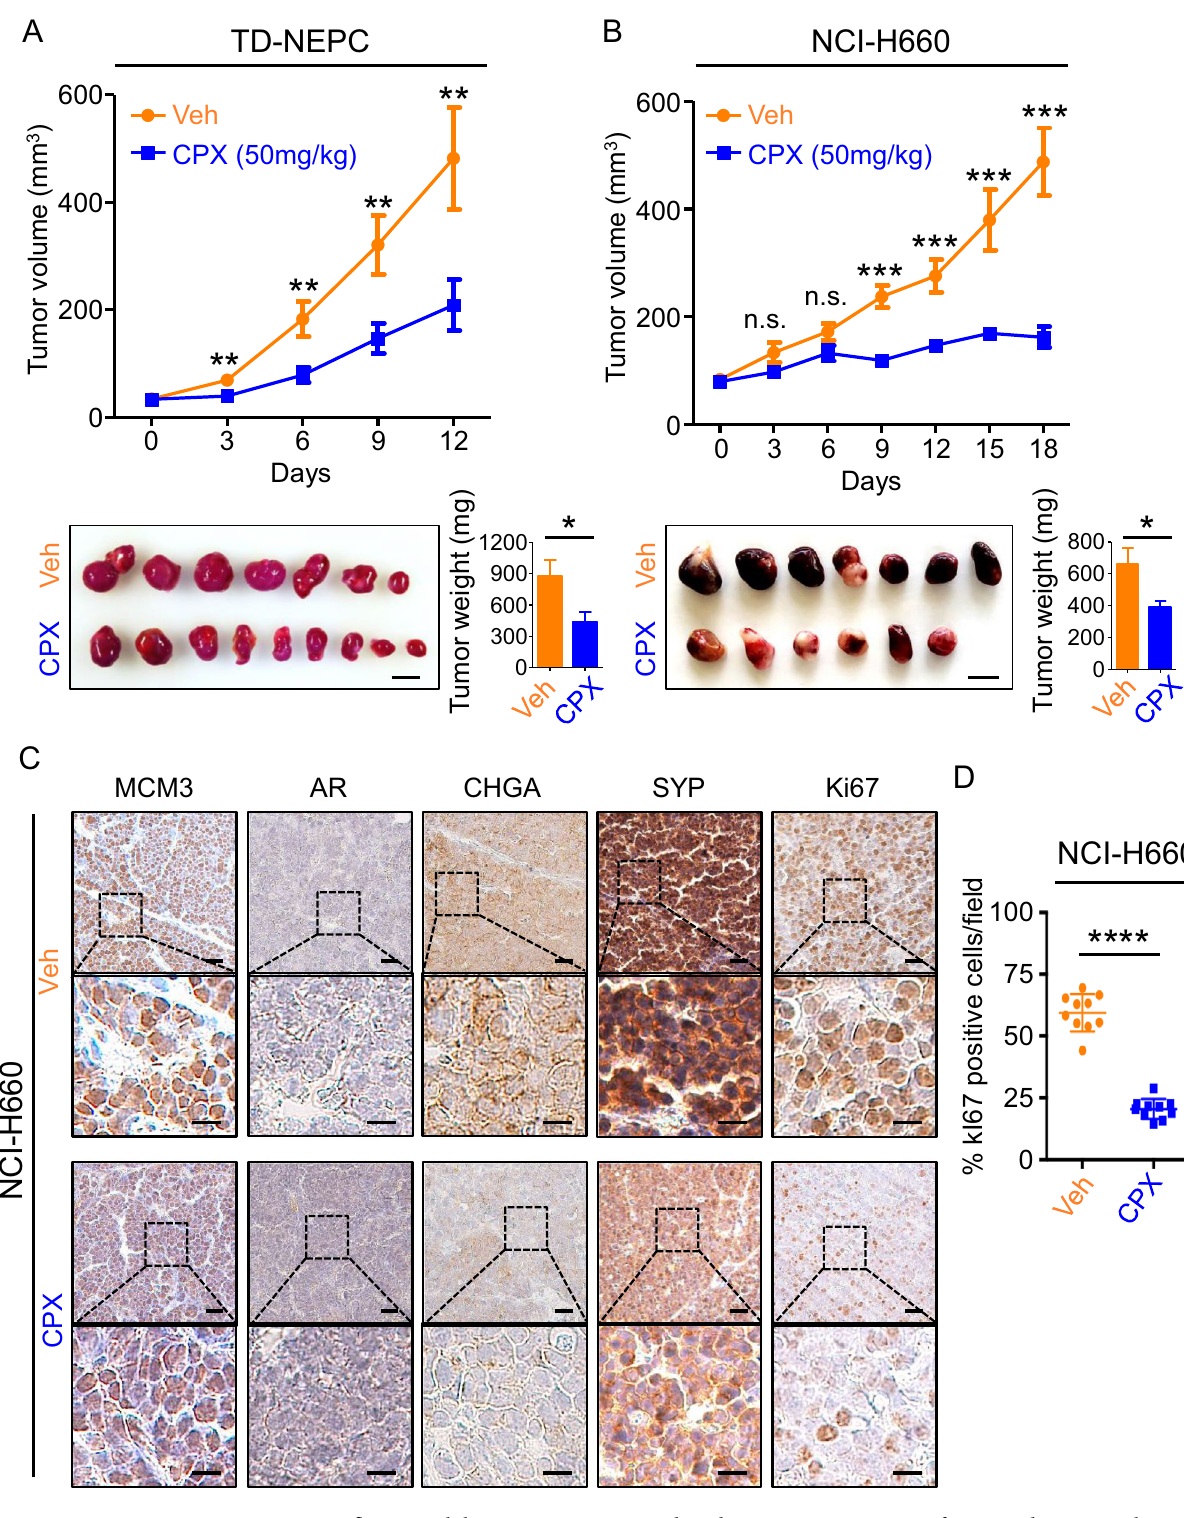
Figure 6. Ciprofloxacin inhibits NEPC tumor growth and suppresses expression of neuroendocrine markers in vivo. ( A , B ) Tumor growth curves, tumor images, and tumor weights of TD-NEPC (tumor n = 7–9) ( A ) and NCI-H660 (tumor n = 6–7) ( B ) treated daily with vehicle or ciprofloxacin (50 mg/kg via intraperitoneal injection). Error bars represent standard error of the mean (SEM). * p < 0.05, ** p < 0.01, ***p < 0.001, and n.s. = not significant, determined by Student’s t test. ( C ) IHC staining for MCM3, AR, CHGA, SYP, and Ki67 in NCI-H660 tumor xenografts treated with vehicle (Veh) or ciprofloxacin (CPX). Scale bars = 25 microns (upper panels) and 10 microns (lower panels). ( D ) Percentage of Ki67-positive cells per image. Error bars represent standard deviation. **** p < 0.0001 by Student’s t